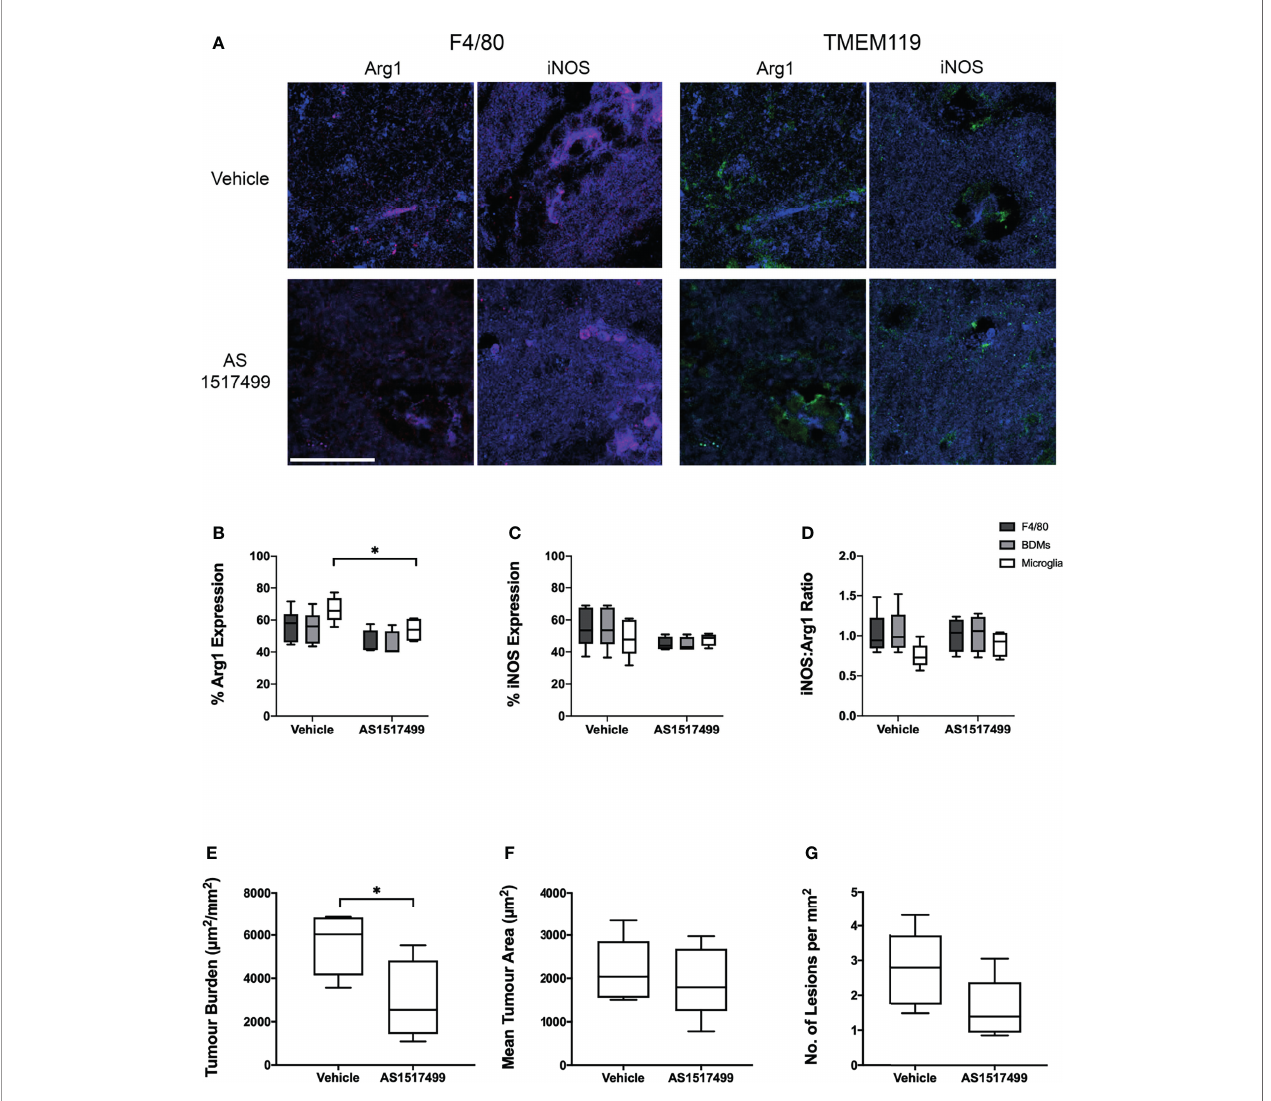
FIGURE 6 | Effect of STAT6 Inhibition in BALB/c mice injected intracardially with 4T1-GFP cells. (A) Representative immuno fl uorescence images from vehicle and AS1517499 treated mice depicting co-expression of F4/80 (red, left panel) with Arg1 and iNOS (blue), and TMEM119 (green, right panel) with Arg1 and iNOS (blue). Scale bar = 40 µm. (B – D) Graphs showing (B) expression of Arg1, (C) expression of iNOS and (D) the ratio of iNOS : Arg1 expression in all F4/80+ cells (dark grey bars), microglia (TMEM119+F4/80+ cells, light grey bars) and BDM (TMEM119-F4/80+ cells, white bars) for vehicle (n = 6) and AS1517499 (n = 5) treated mice. (E – G) Graphs showing (E) tumour burden measured as total area of metastases divided by total tissue area analysed, (F) average tumour area, and (G) average number of metastases per square mm of tissue analysed. Data shown as box and whisker plots depicting full range of data points. *p <